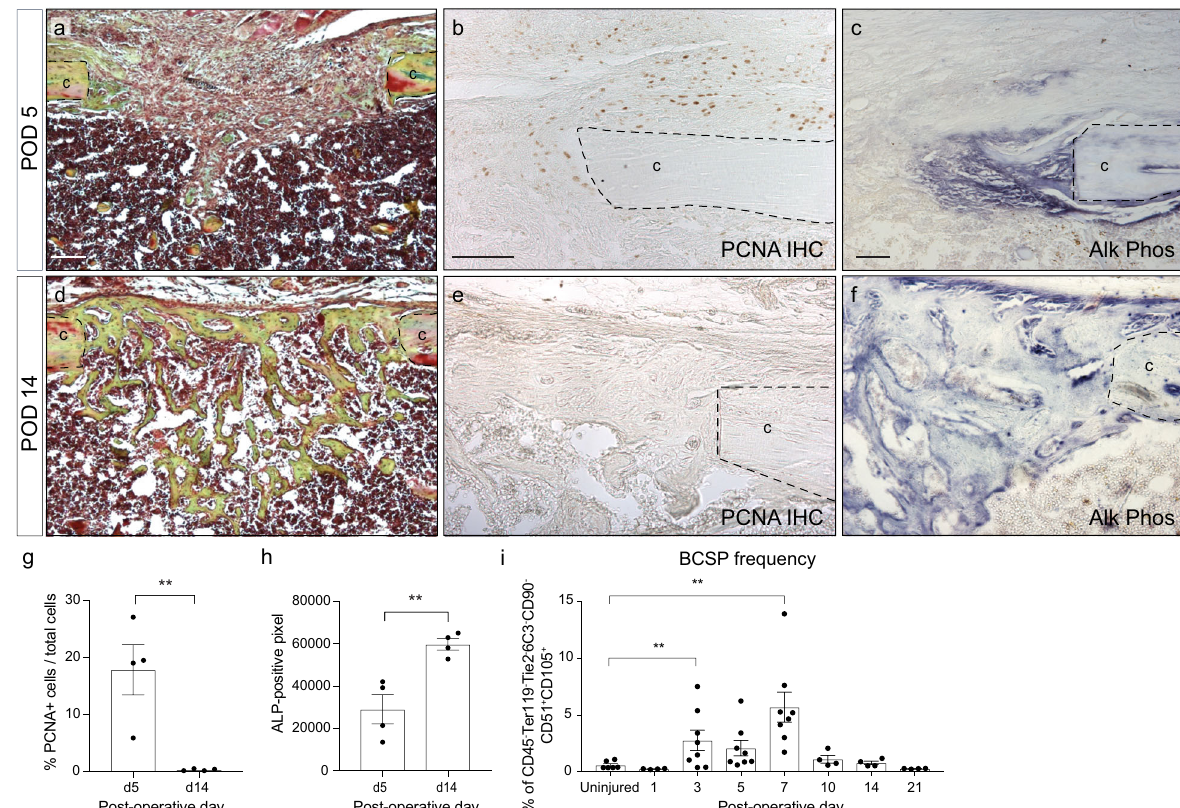
Fig. 1 Temporal separation of proliferation and differentiation during tibial defect healing. a Histological section of tibial mono-cortical defects 5 days after injury, stained with Movat ’ s Pentachrome. The defect site is fi lled with soft tissue. b PCNA IHC shows active proliferation in the periosteum and defect site at this early time point. c Alkaline phosphatase staining demonstrates only a small region of osteogenic differentiation at the cortical edge. d After 14 days, the defects site is fi lled with woven bone, stained yellow-green with Pentachrome. e PCNA staining reveals absence of proliferation within the injury. f Alkaline phosphatase staining indicating osteogenic differentiation throughout the injury site. g Quanti fi cation of PCNA-positive cells in the injury site at POD 5 and 14. h Quanti fi cation of alkaline phosphatase staining at POD 5 and 14. i Frequency of bone-cartilage-stromal progenitor cells (BCSPs) was analyzed over the time course of fracture healing by fl ow cytometry using the following BCSP markers: CD45 − Ter119 − Tie2 − CD51 + CD90 − 6C3 − CD105 + . Scale bar = 100 μ m. ALP alkaline phosphatase, BCSP bone-cartilage-stromal progenitor cells, c cortical bone, PCNA proliferating cell nuclear antigen, POD postoperative day. ** p < 0.01. Data were represented as mean ±